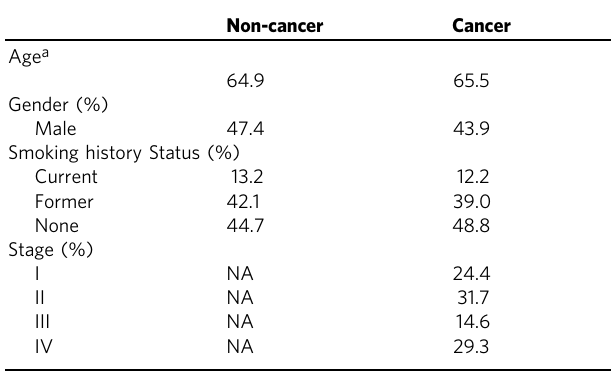
Table 1 Clinical characteristics of non-cancer and cancer subject